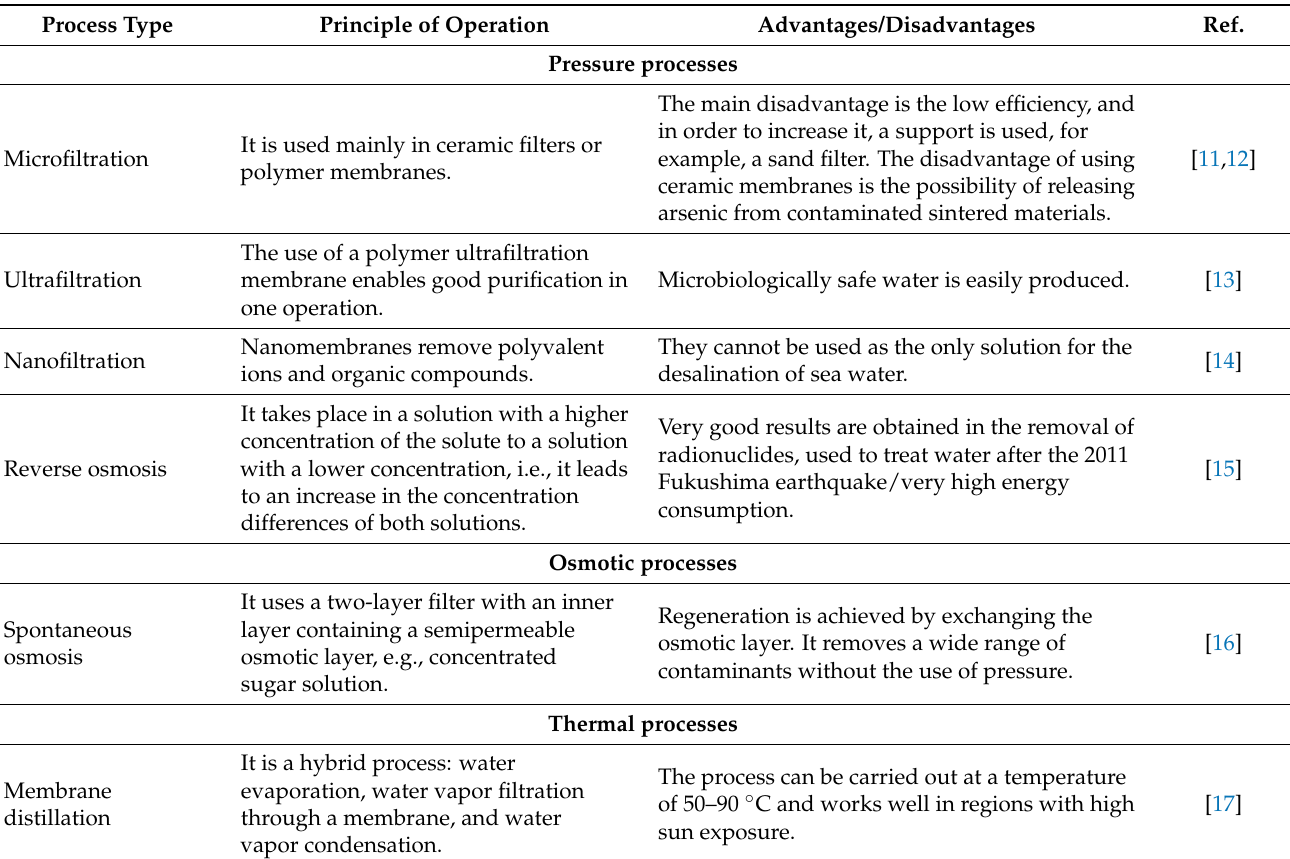
Table 1. Membrane water-purification processes for potential use in water purification in hazardous areas. Process